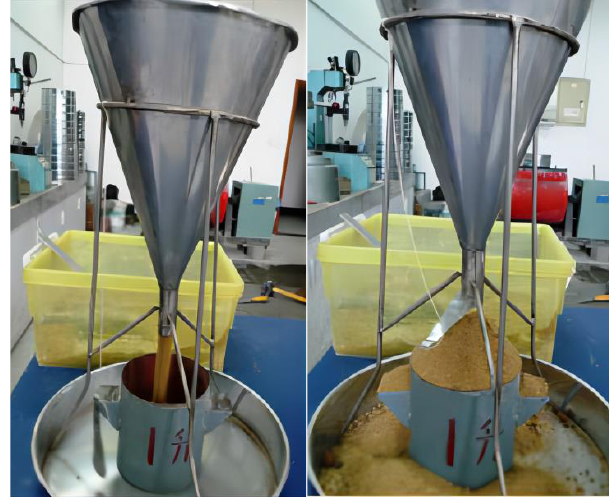
Figure 3. Feeding funnel charging .